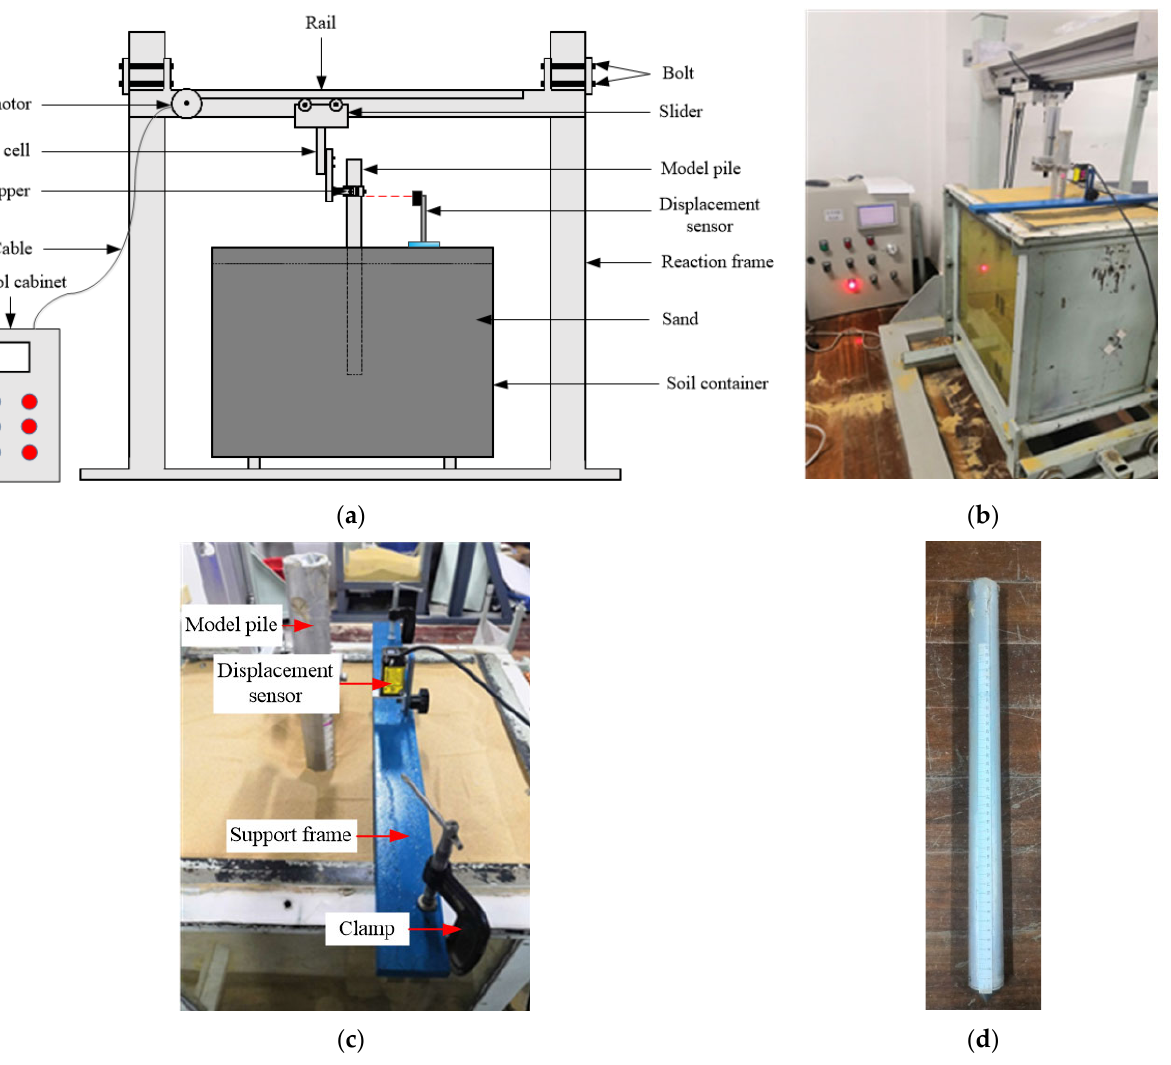
Figure 1. Test system: ( a ) schematic sketch; ( b ) photo; ( c ) displacement measurement; ( d ) model pile.